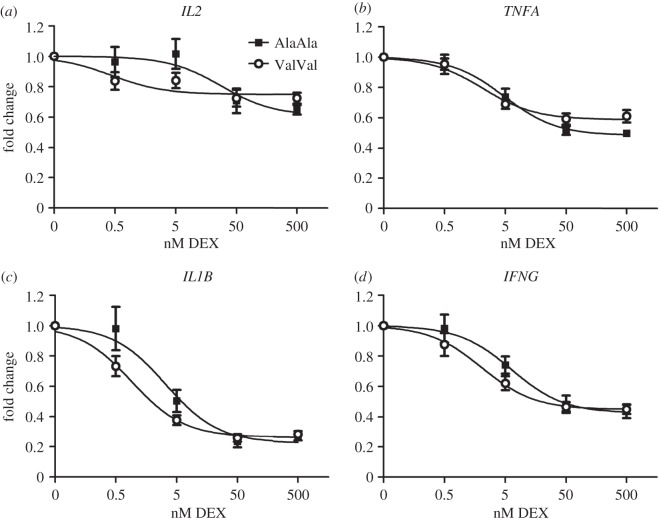
Transcriptional repression in ConA-stimulated PBMCs in response to DEX treatment ex vivo: (a) IL2; (b) TNFA; (c) IL1B; (d) IFNG. Gene expression was measured using quantitative real time PCR. Data are presented as dose–response curves estimated based on fold-changes calculated within each individual relative to control treatment with ConA but without DEX. Individual points show means ± s.e. Estimated half-maximal inhibitory concentrations (IC50) for AlaAla (n = 9) compared to ValVal (n = 10) carriers were: (a) 28.35 versus 0.442 nM (p = 0.006) for IL2; (b) 4.791 versus 2.151 nM (p = 0.076) for TNFA; (c) 6.331 versus 2.063 nM (p = 0.042) for IL1B; (d) 3.330 versus 0.911 nM (p = 0.004) for IFNG.